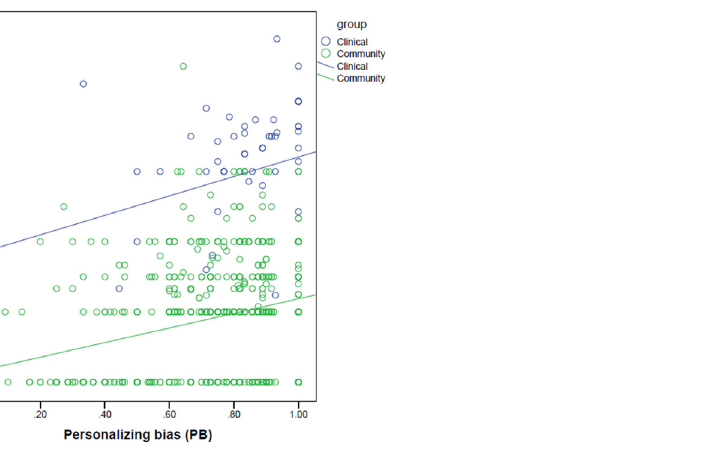
Fig 3. Association between attributional biases and level of delusional distress.